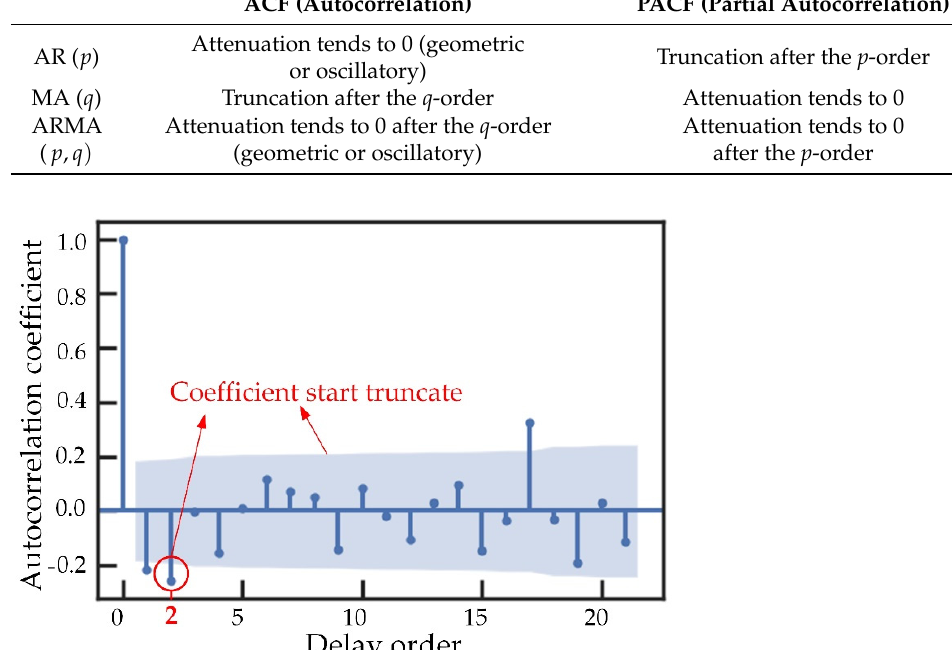
Table 5. ARIMA ( , , p d q ) order determination.